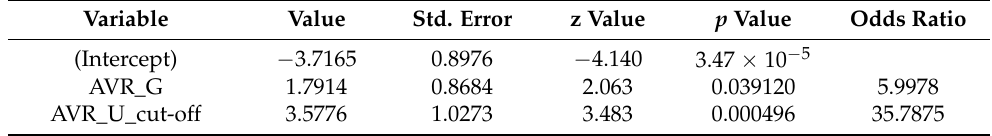
Table 5. Estimation results for the low vs. rest